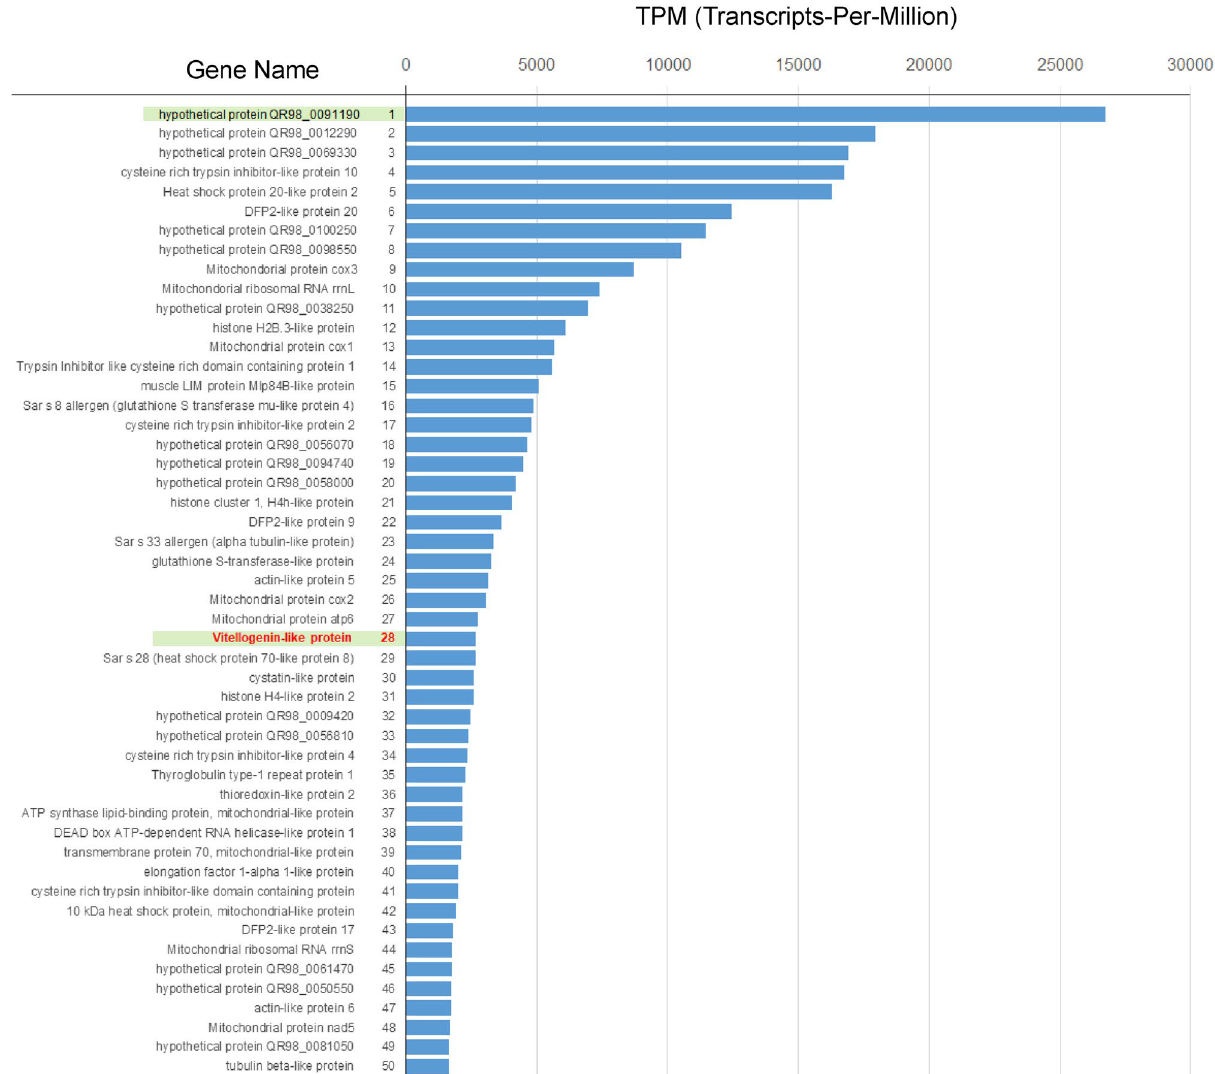
Figure 2. Transcript abundances of annotated genes in the S. scabies transcriptome. Top 50 genes ranked according to expression level in terms of transcripts-per-million (TPM) for each sample are shown as a